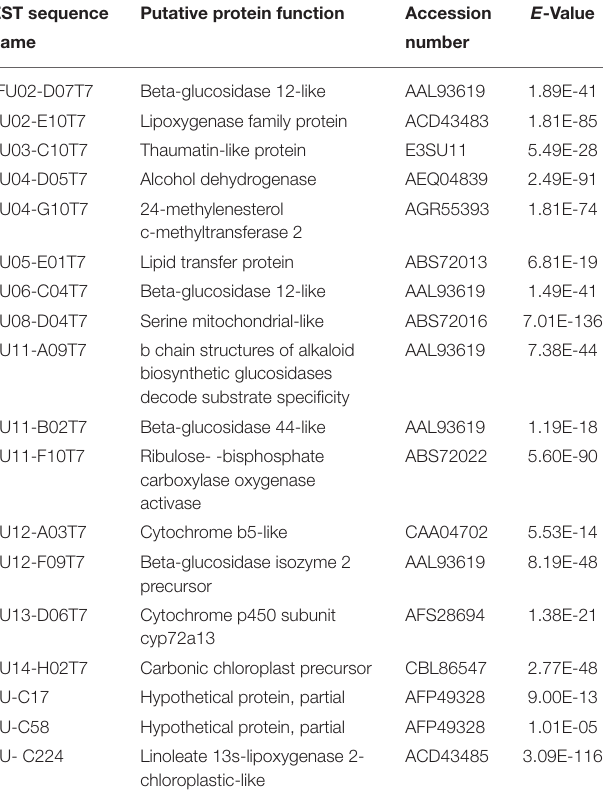
TABLE 4 | List of repressed EST sequences identified after Blastx analysis as homologous to olive genes previously indexed in databases. EST sequence Putative protein